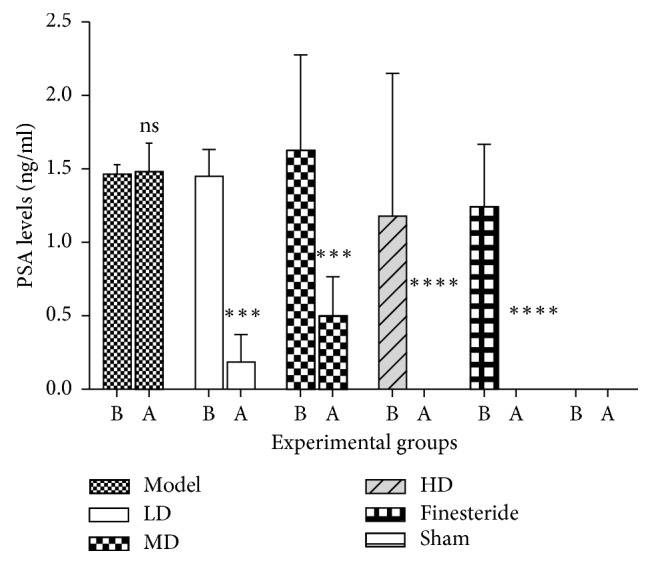
Mean serum PSA level before and after treatment for various experimental groups. Data are presented as mean ± standard error of mean (n = 6) (ns = no significance, ∗∗∗p < 0.05 and ∗∗∗∗p < 0.0001). B represents before treatment, and A represents after treatment. There was a decrease in the serum PSA levels of all treatment groups compared to the disease control (testosterone) group. The low-dose, mid-dose, and high-dose Citrus aurantifolia groups all produced a significant reduction in serum PSA levels, together with the finasteride and normal control groups. This implies that the reduction in serum PSA levels was statistically significant, upon treatment with all doses of Citrus aurantifolia. A greater and more significant decrease was observed in the high-dose group than the low-dose and the mid-dose groups.